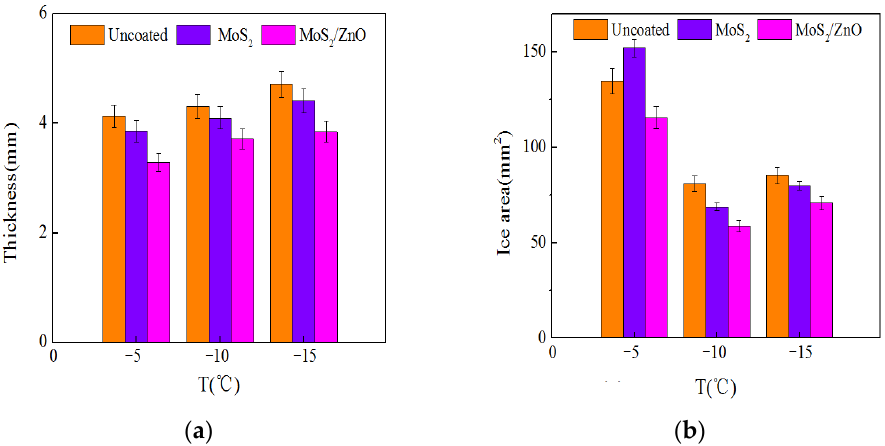
Figure 14. Icing conditions of blade leading edges coated with di ff erent materials under various ambient temperatures and at wind speeds of 10 m/s: ( a ) icing thickness ( b ) icing